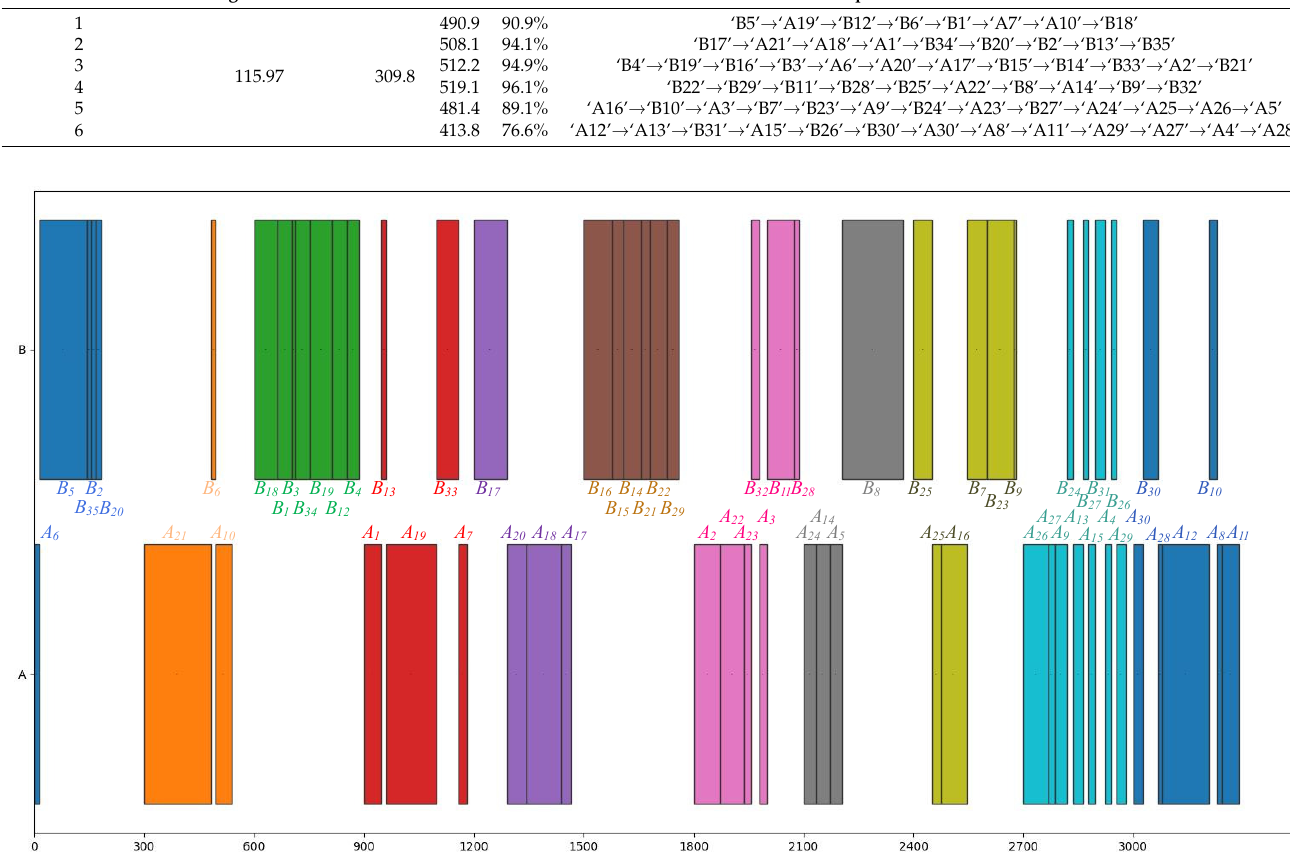
Figure 8. The Gantt chart of optimal solution ( CT 1 = 50, CT 2 =